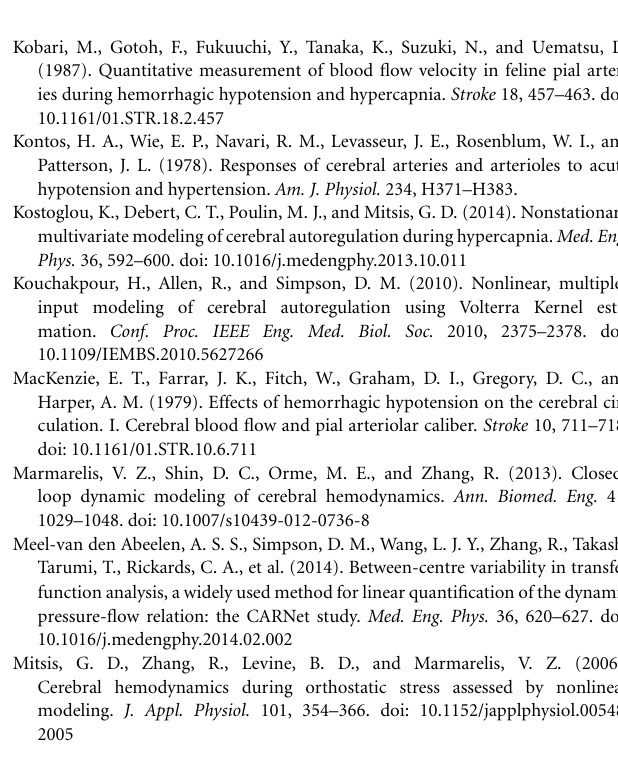
(dashed line). Each circle indicates a pair of the corresponding means of phase and gain calculated at each frequency step for the investigated subjects; as a result of the different frequency steps, the number of pairs